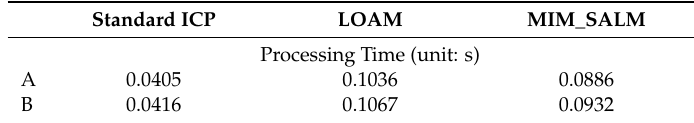
Table 2. The average time consumption per frame for different approaches/scenes.